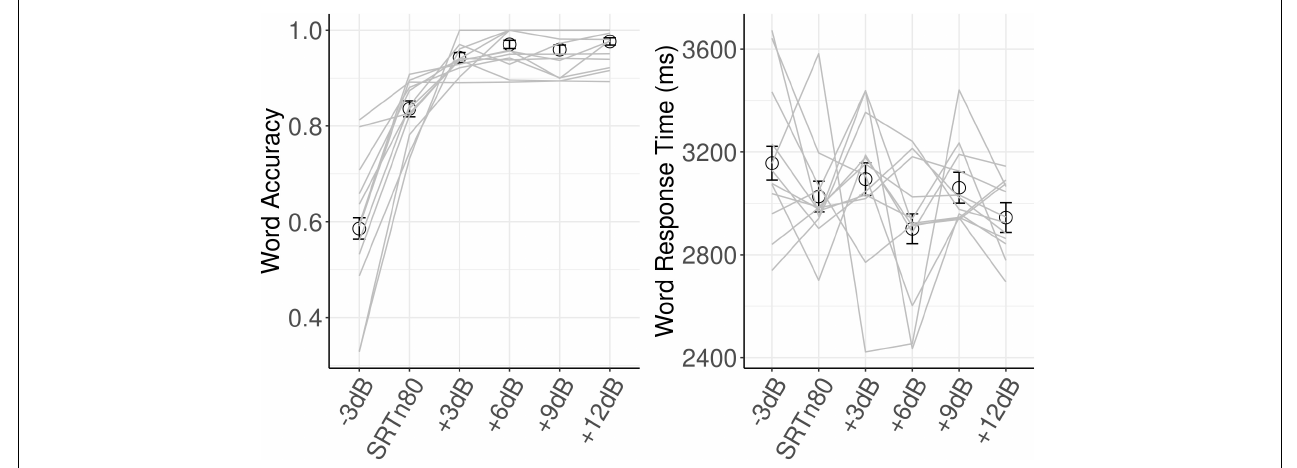
FIGURE 2 | Behavioral results. Error bars show ± 1 SE, where SE is scaled to represent within-subjects variance for the repeated-measures design (Cousineau, 2005). Gray lines show individual participants. SRTn80, the signal-to-noise ratio that approximates the 80 percent speech recognition threshold for each